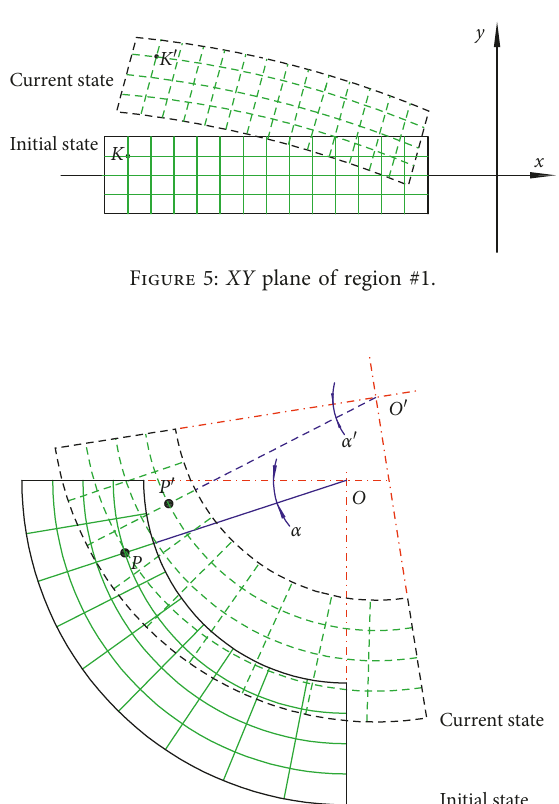
Figure 6: XY plane of region